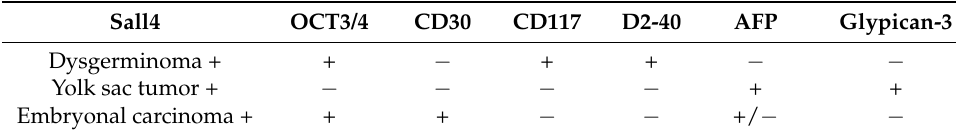
Table 3. Immunohistochemical markers of